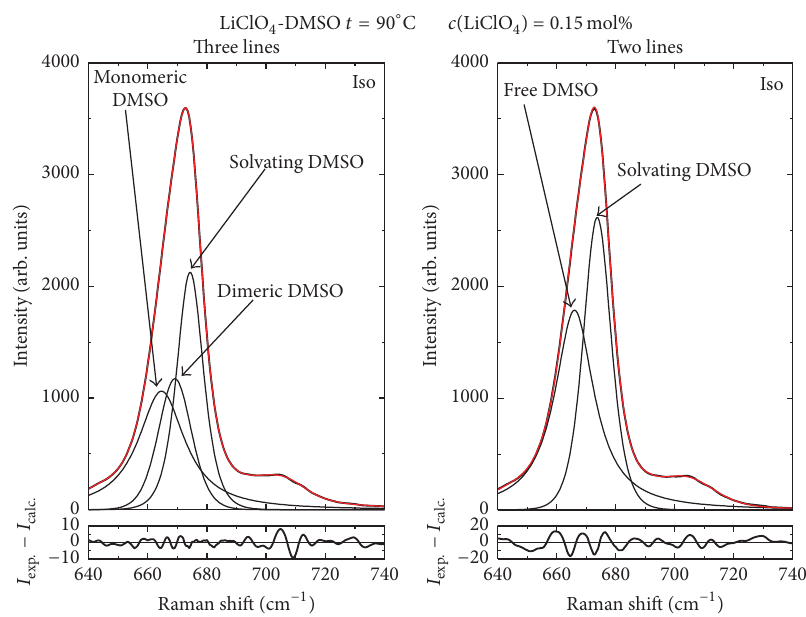
Figure 4: Representative example of data fits with (three lines) and without (two lines) distinguishing between monomeric and dimeric molecules of the solvent in the DMSO solution containing 0.15 mole fractions of LiClO 4 .